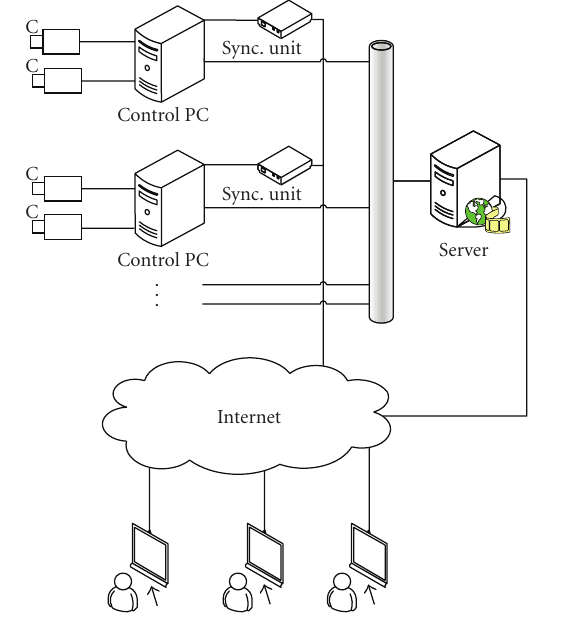
Figure 1: System architecture.